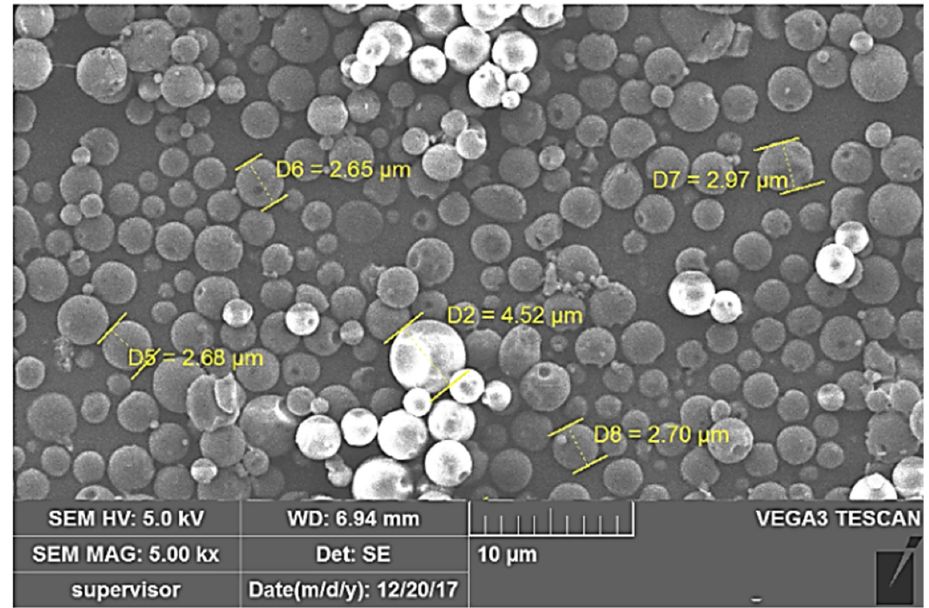
Figure 2. Surface morphology of the optimized formula of LVX-loaded